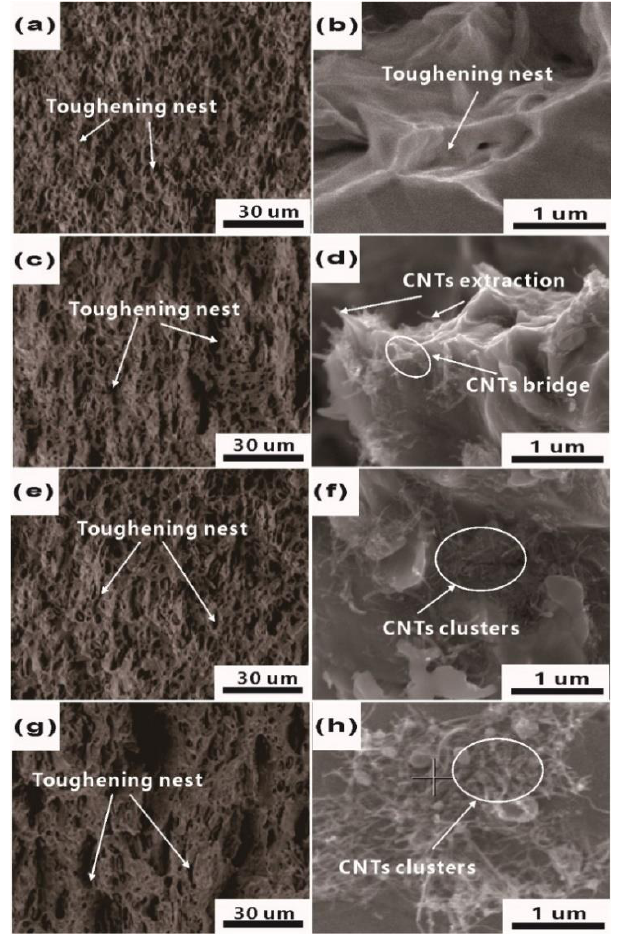
Figure 6. SEM micrographs of fractured surfaces of Cu/CNT composites containing ( a,b ) 0.3, ( c,d ) 0.6, ( e,f ) 1.2, and ( g,h ) 1.8 vol.% CNTs after tensile tests.